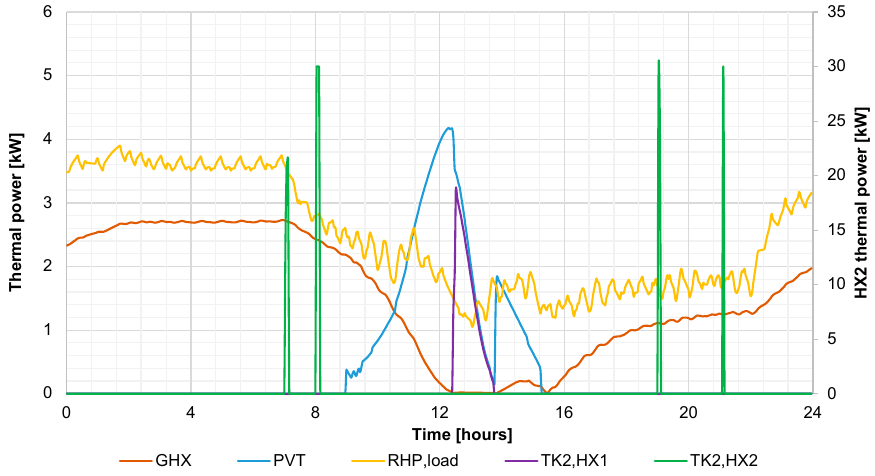
Figure 7. Main thermal powers of the system, daily analysis, winter day.